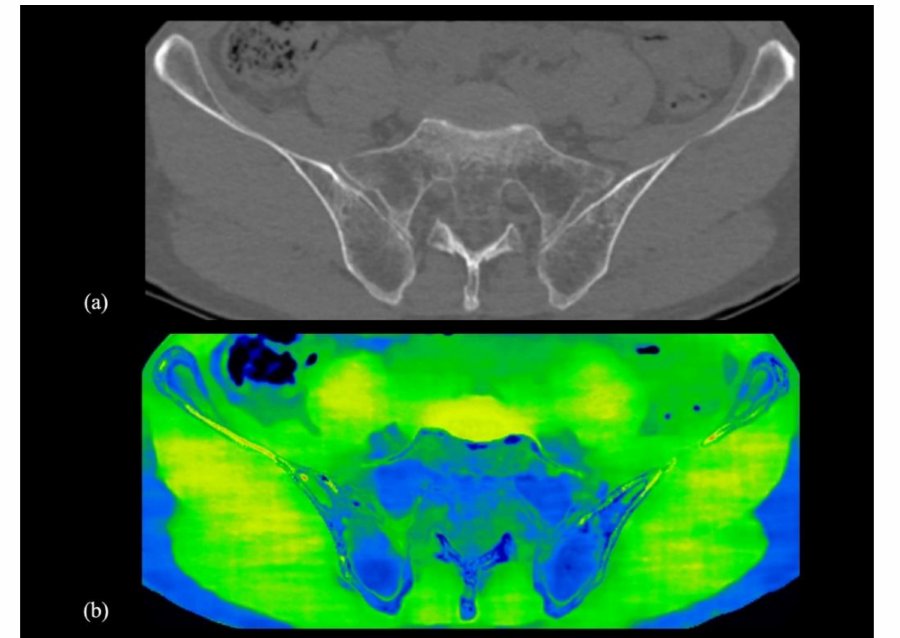
Figure 5. Axial view of the pelvic bones of conventional CT image and water-HAP image in an oncologic patient without bone metastasis in his 70s. ( a , b ) The pelvic bone’s water density is comparable to that of subcutaneous adipose tissue and lower symmetrically than that of skeletal muscle. This finding suggests the absence of bone tumours. HAP;